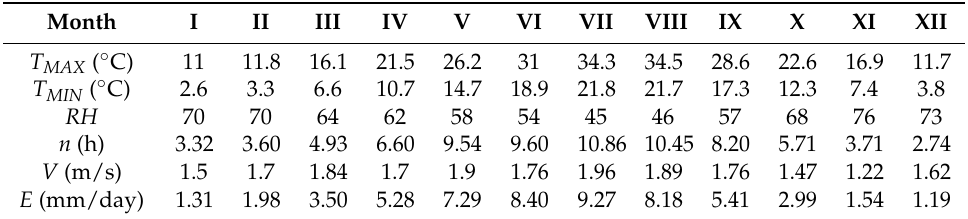
Table 6. Input meteorological parameters and calculated water evaporation from The Skadar Lake for an average day in each month.